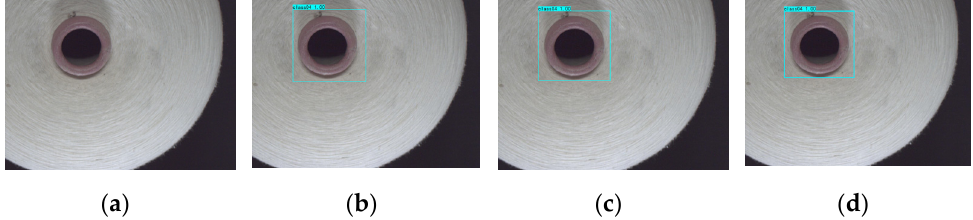
Figure 15. Identification of dirty cone yarn: ( a ) original image; ( b ) YOLOv3 + DarkNet-53 algorithm recognition results; ( c ) Faster R-CNN + VGG16 algorithm recognition results; ( d ) Faster R-CNN + ResNet50 algorithm recognition results.